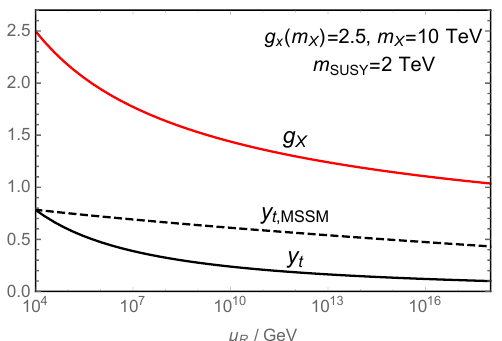
Figure 1 . RG running of the gauge coupling g X (red) and the top Yukawa coupling y t for m X = 10 TeV, m SUSY = 2 TeV, g X ( m X ) = 2 :